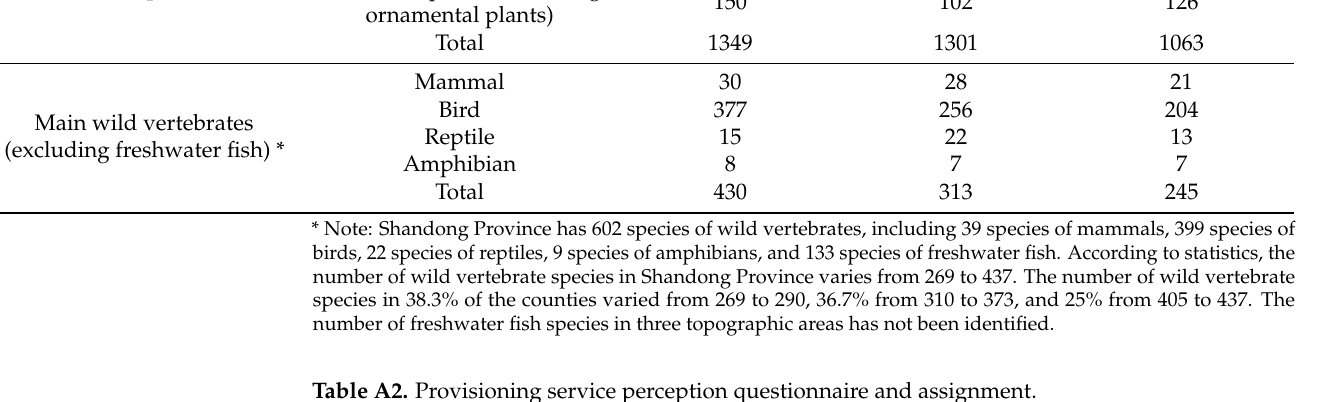
Table A2. Provisioning service perception questionnaire and assignment.